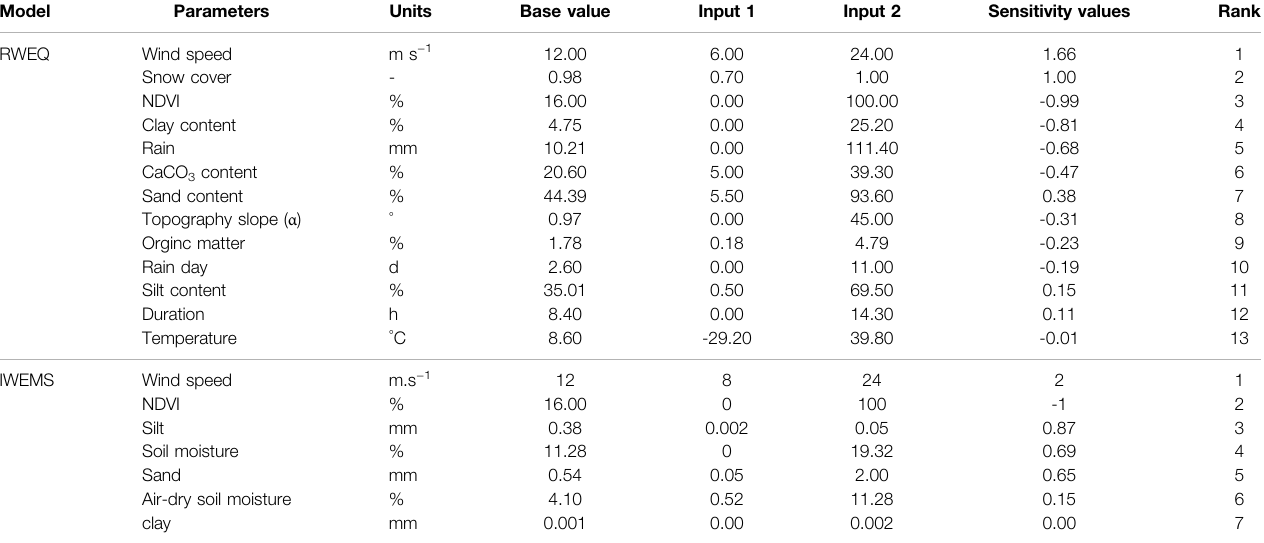
TABLE 3 | The values of testing parameters, base values, input values and sensitivity values in RWEQ and IWEMS. Model